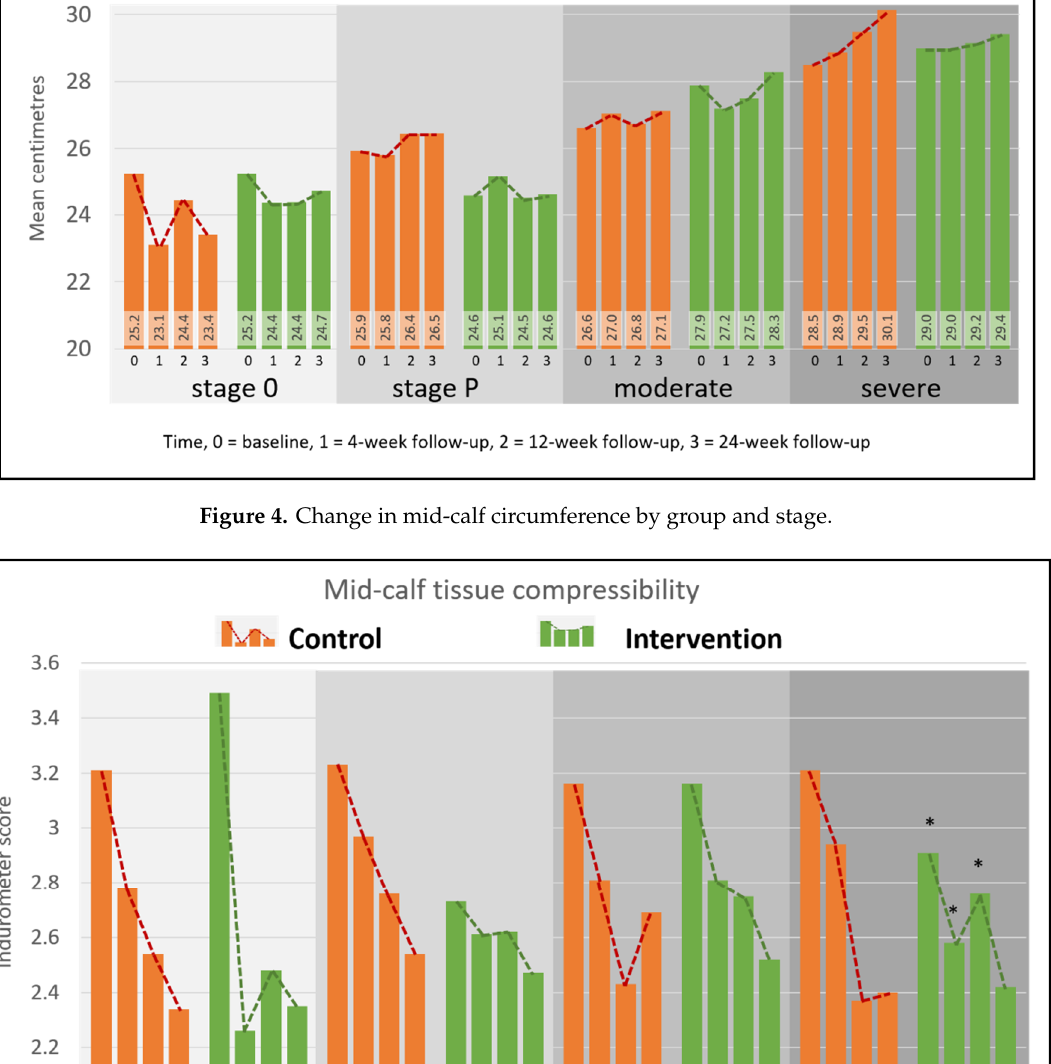
Figure 4. Change in mid-calf circumference by group and stage.